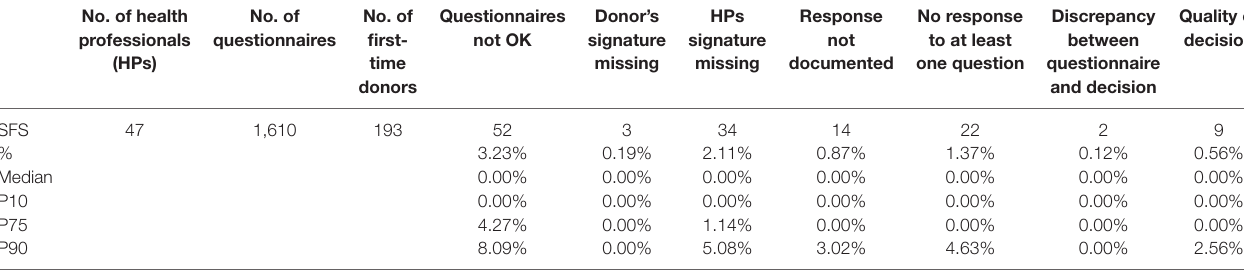
TaBle 3 | Monitoring of donor health questionnaires (more than 500 pre-donation interviews). no. of health